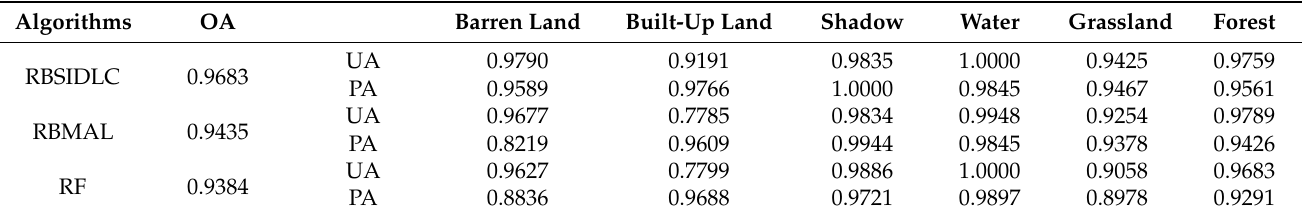
Figure 6. Classification diagram based on preferred features: ( a ) RBSIDLC; ( b ) RBMAL; ( c ) RF. And two subsets classification diagram (Subset (1) and Subset (2)). Subset (1): ( d ) RBSIDLC; ( e ) RBMAL; ( f ) RF. Subset (2): ( g ) RBSIDLC; ( h ) RBMAL; ( i ) RF. Table 5. Class-specific and OA results of the three methods for “preferred features”. The values in this table correspond to the classification results in Figure